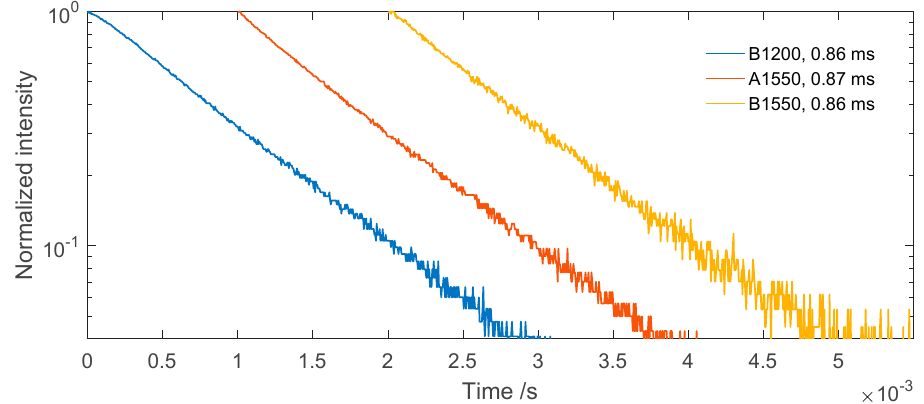
Table 5. Fluorescence lifetime of fibers derived from the sol-gel granulated silica method.